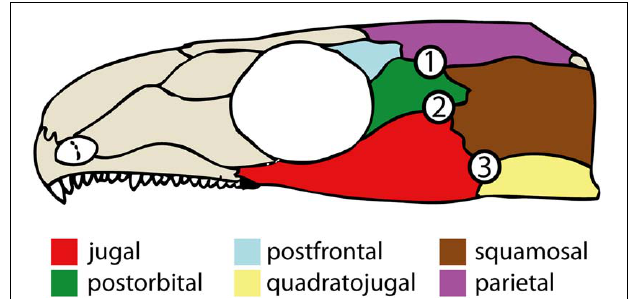
FIGURE 14 | Drawing of the skull of Captorhinus aguti after Fox and Bowman (1966) with possible origin sites for temporal openings in the hypothetical ancestral amniote. 1, squamosal-postorbital-parietal intersection; 2, jugal-squamosal-postorbital intersection; 3, jugal-squamosal-quadratojugal intersection. Sites 1 and 2 are the most likely origin sites for a taxon similar to Captorhinus . Site 3 occurs especially in Parareptilia. Temporal openings in early Synapsida and Diapsida formed probably by fusion of two of such origin sites (see also Werneburg and Abel,